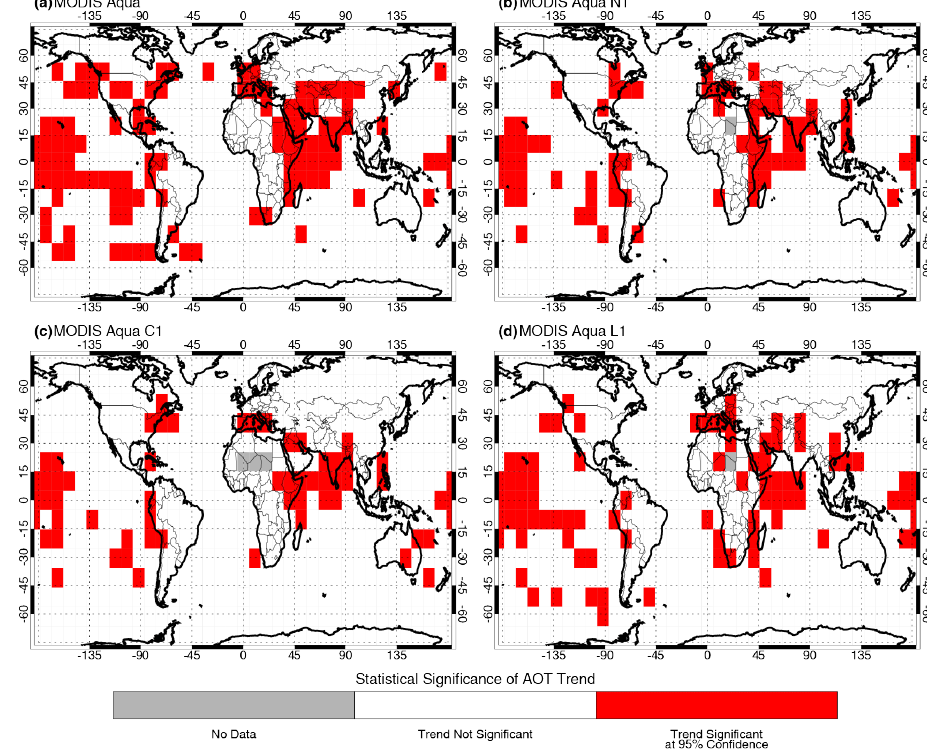
Figure 15. As in Fig. 14, but for the 95% statistical significance